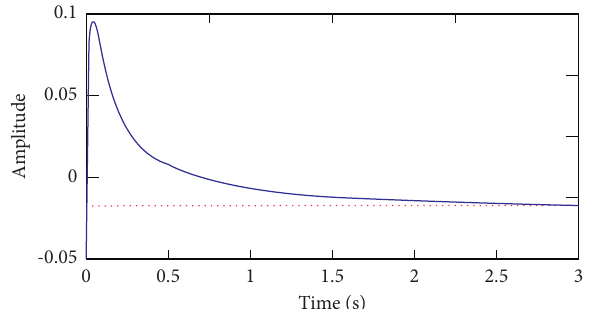
Figure 4: Unit step response curve of e